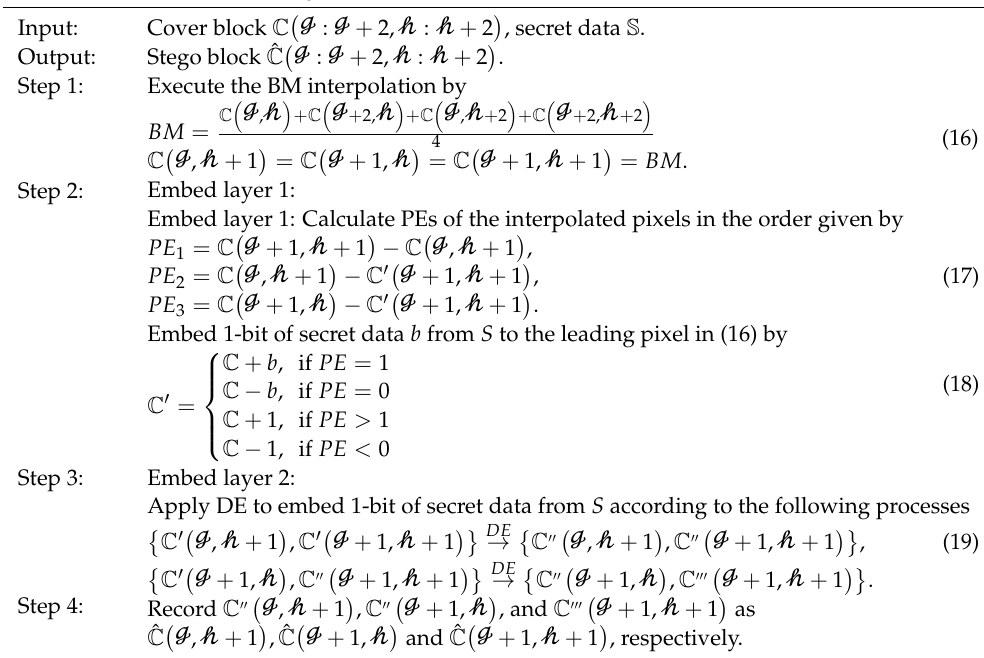
Algorithm 3 Data Embedding for Smooth Blocks